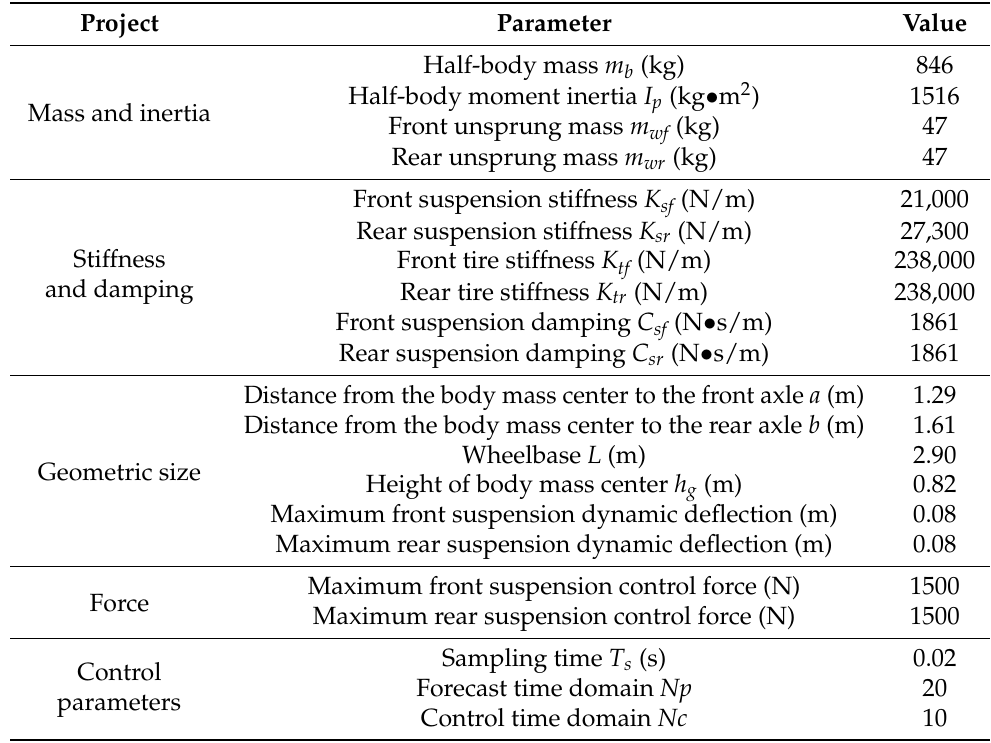
Table 1. Main technical parameters of the electric